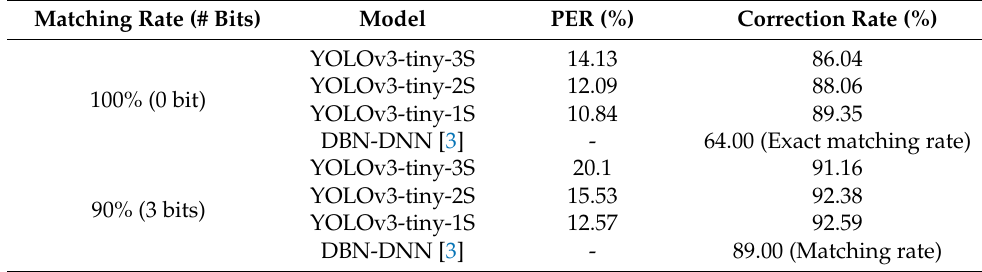
Table 5. PER (%) and correction rate (%) for our proposed AFD-Obj system and results of [3]. Matching Rate (# Bits) Model PER